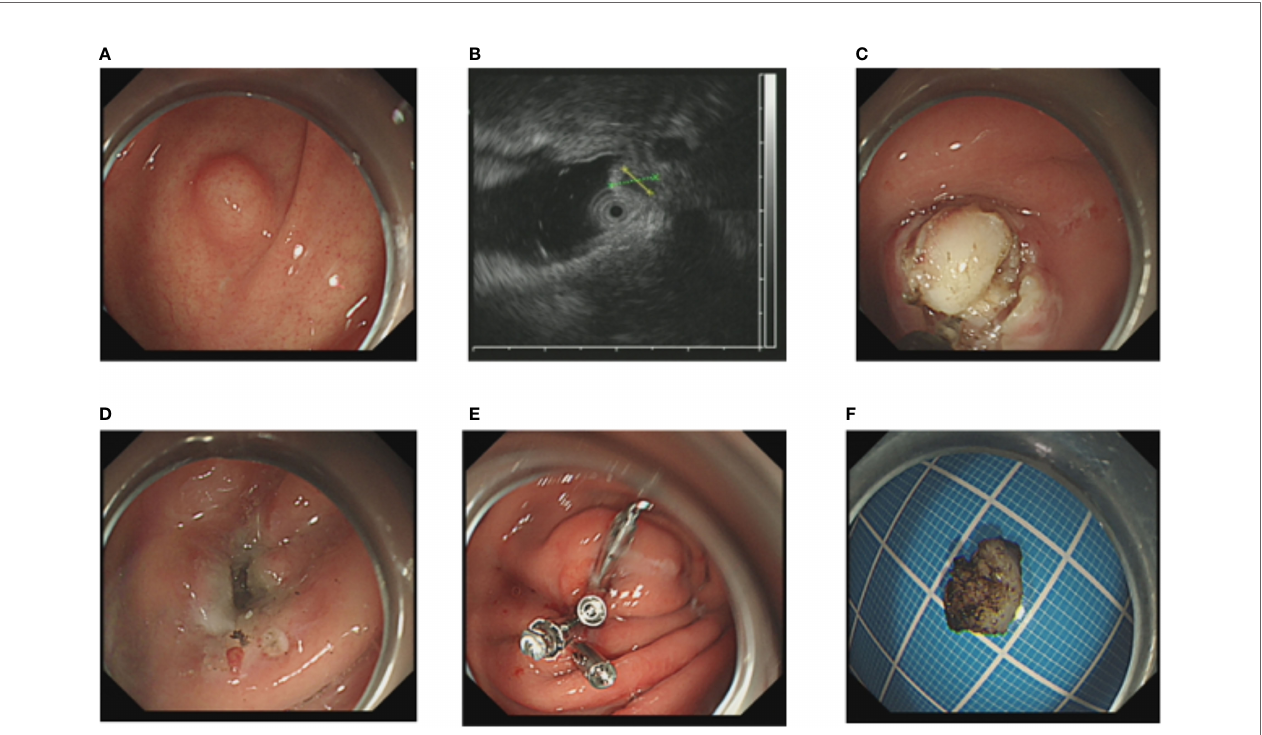
FIGURE 2 | The NIE endoscopic submucosal dissection of a gastric GIST. (A) A gastric GIST is observed. (B) The tumor originates from the muscularis propria layer on EUS. (C, D) Without submucosal injection, endoscopic submucosal excavation of the tumor is directly performed using a Hook knife and the lesion is removed completely. (E) The gastric wall defect was managed by clips. (F) View of the tumor after resection.